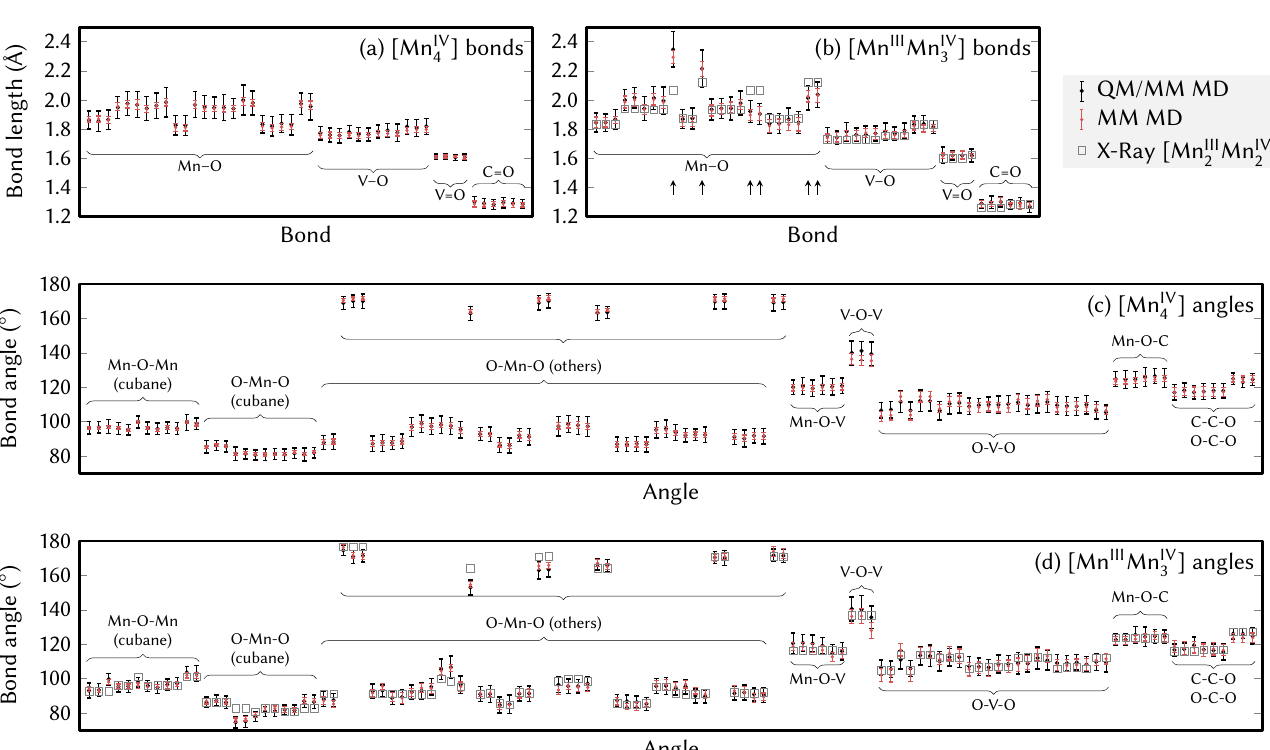
Figure 2. Comparison of the bond and angle averages (dots) and standard deviations (error bars) between the QM/MM MD reference trajectory (black) and the MM MD trajectory with the final FF parameters (red). Panels ( a , b ) show the averages and standard deviations of the bond lengths, whereas panels ( c , d ) show the corresponding data for the bond angles. In ( b , d ), rectangles show the bond lengths from X-ray crystallography for comparison [17]. Bond lengths discussed in the text are marked with arrows in ( b